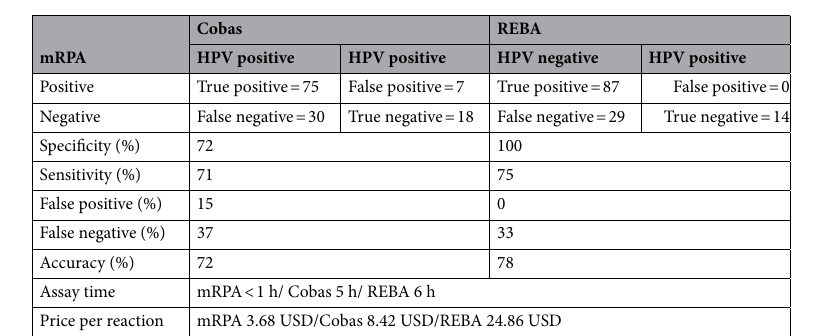
Table 4. Comparison of our developed assay (mRPA) to conventional diagnostic assays (Cobas and REBA) on 130 clinical DNA